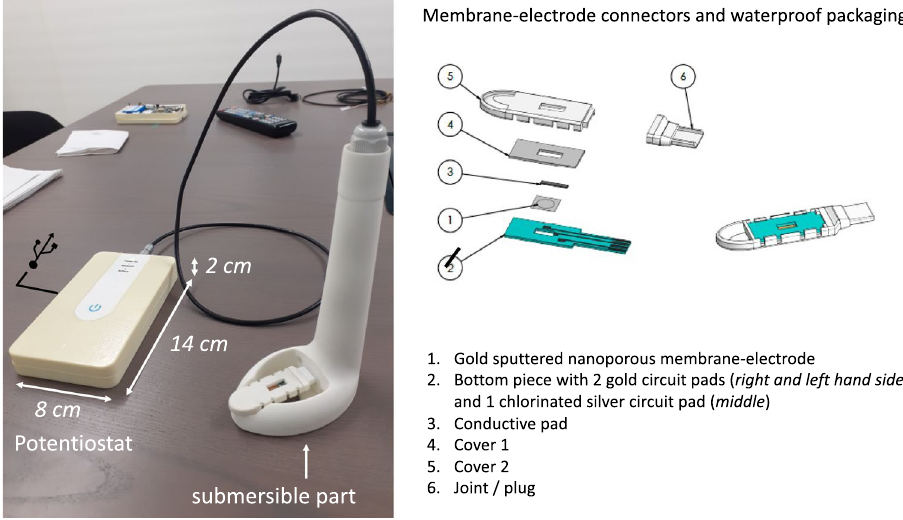
Figure 2. Photo of the home-made portable electrochemical sensor prototype named CAPTOT—adjacent figure: designed pieces for clipsing and connecting functionalized nanoporous membrane-electrode to the